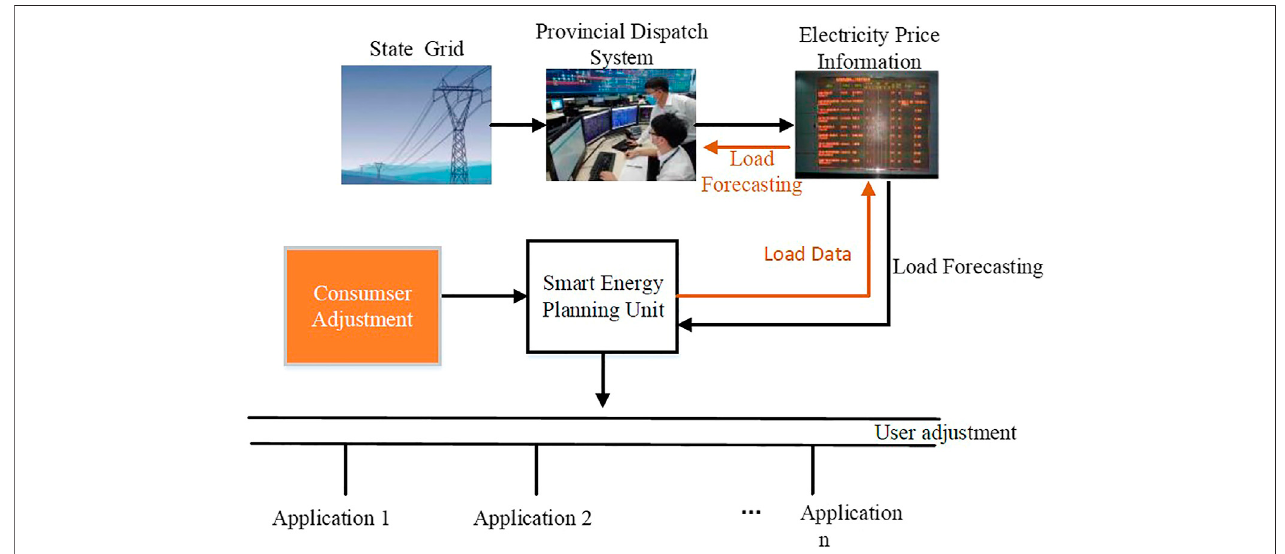
FIGURE 5 | Schematic diagram of the smart energy planning